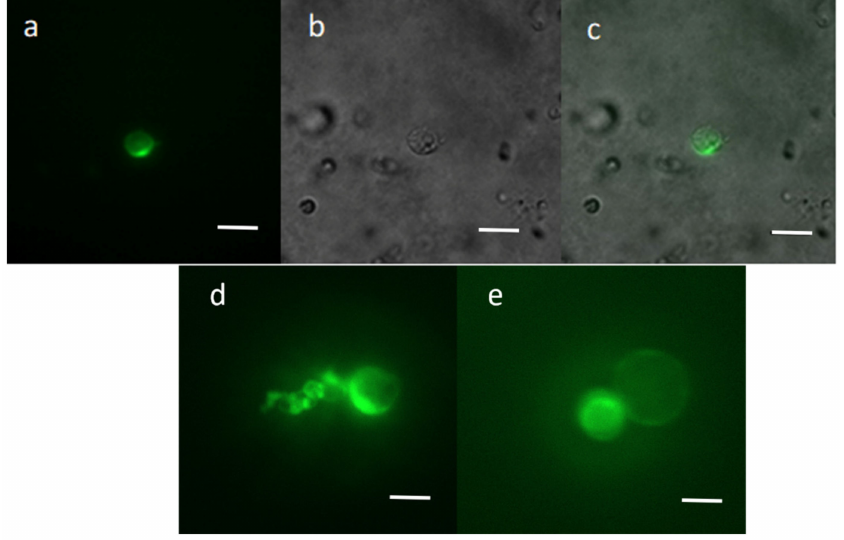
Figure 2. Protoplasts transfected with the pAVA393 plasmid containing the GFP expression cassette. The GFP signal was detected by fluorescence microscopy 72 h after the transfection event, under blue light ( a , d , e ), white light ( b ) and fusion of the two images ( c ). Scale bar = 100 µ m. In order to obtain reproducible results, high transfection values (>50%) are